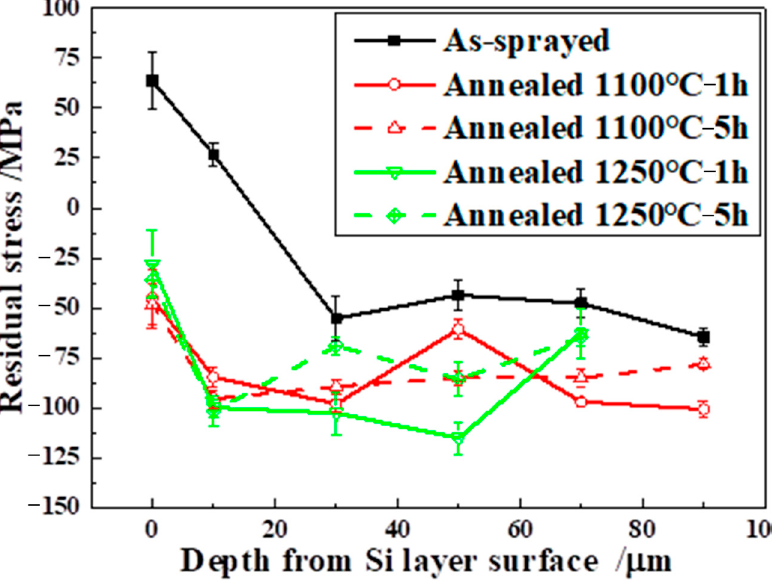
Figure 13. Residual stress variations along the depth of the as-sprayed and annealed Si layer.